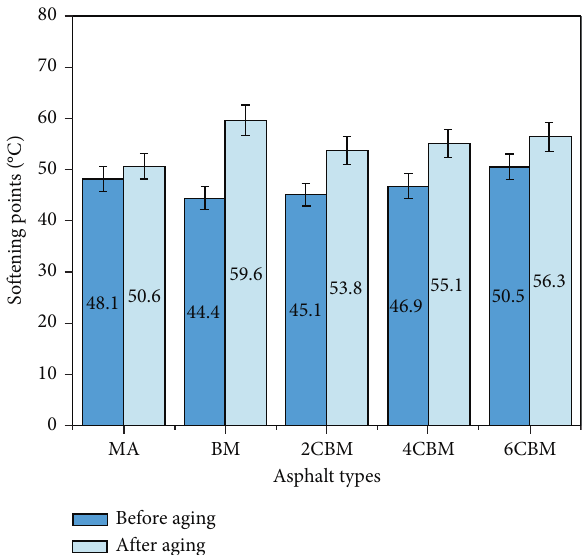
Figure 5: Effect of organic nano-CaCO 3 on softening point of bioasphalt before and after